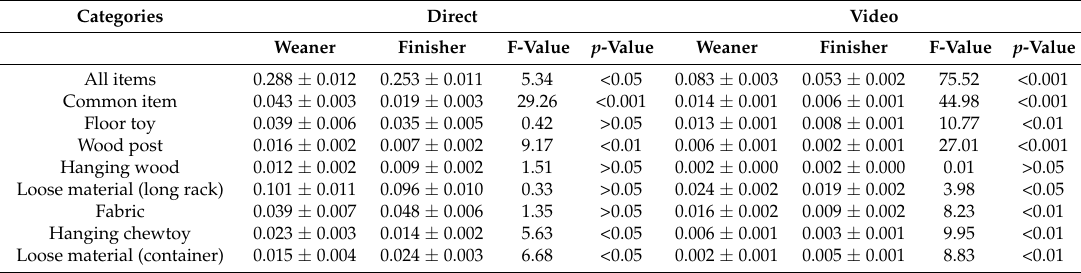
level, as the mean ± S.E. ( n =